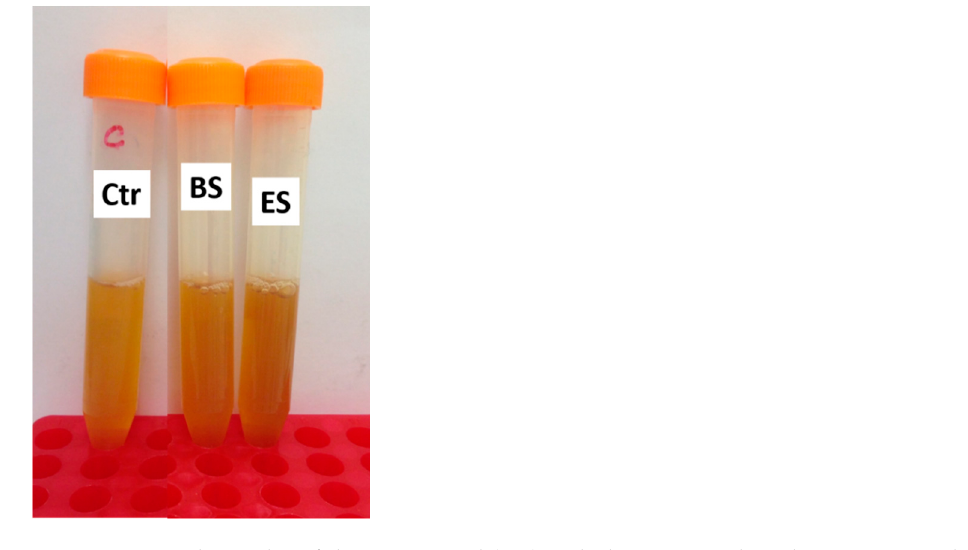
Figure 4. Typical samples of the non-treated (Ctr) and plasma-treated apple juice using a batch sys- tem (BS) and electrospray system